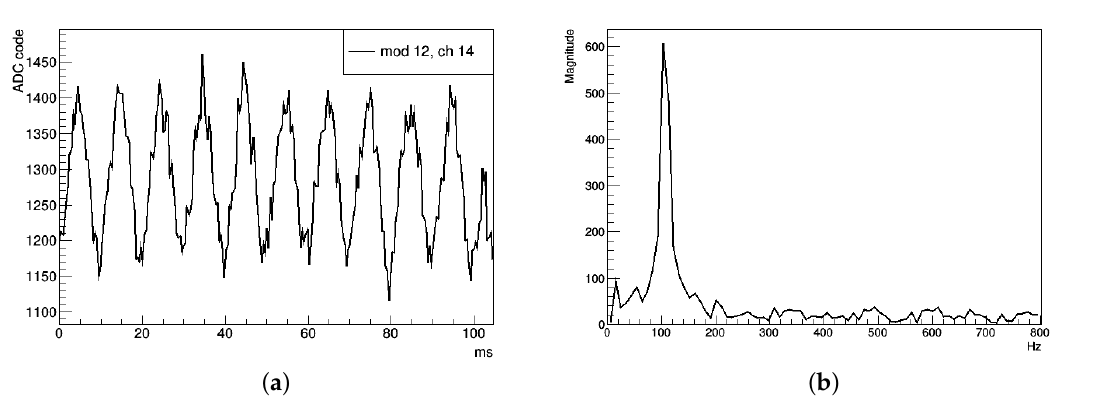
Figure 17. ( a ): a waveform measured above Greece on 21 August 2016 at 21:57:21 UTC. ( b ): the result of its Fourier